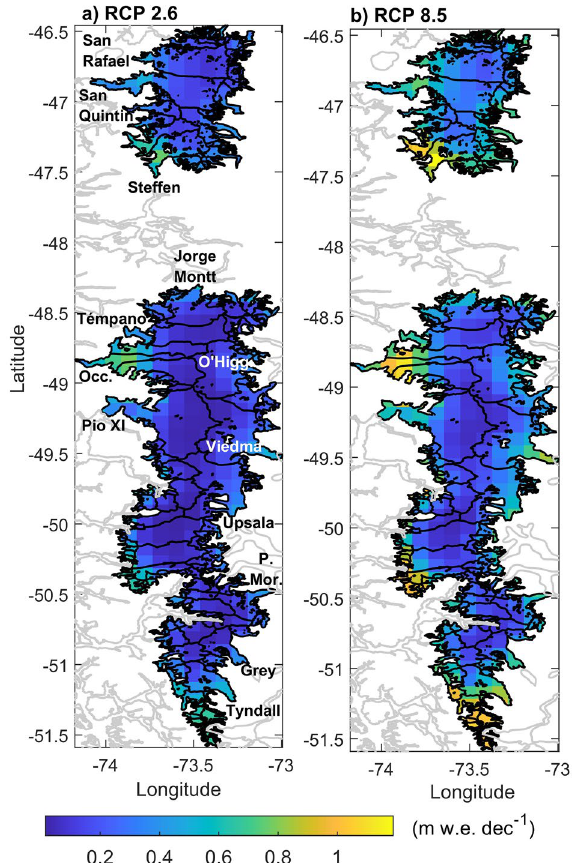
Figure 6. Spatially distributed melt trends over the Patagonian Icefields estimated with the EBM. Trends are from hydrological year 1976/77 to 2049/50, following after 2005 the pathway scenario RCP 2.6 ( a ) and the pathway scenario RCP8.5 ( b ). Black lines are the glacier basins and grey lines are coast lines. All the grid points are significant (p <